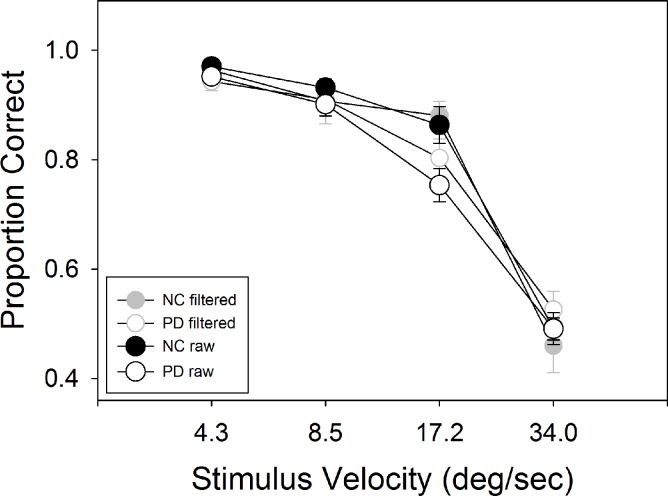
Results of Experiment 1.PD showed lower accuracy than NC overall (p = .049) for the raw dataset, but not when using the filtered dataset based on only trials where subjects maintained fixation.